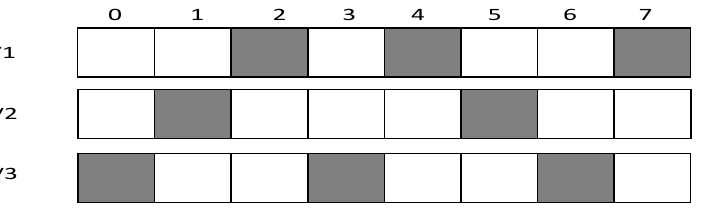
Figure 13. Minimum transmission delay model.